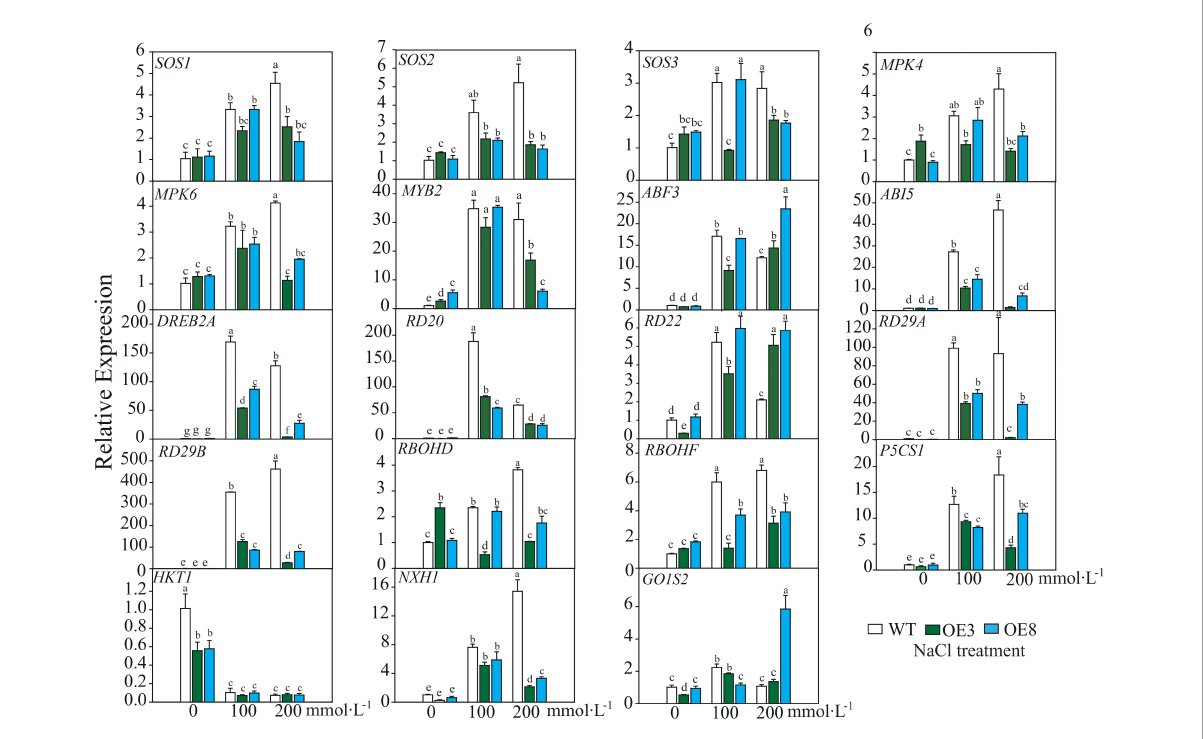
FIGURE9 Relative expression of salt stress responsive genes of WT and OE lines. SOS , Salt Overly Sensitive; MPK, mitogen-activated protein kinas; MYB, V-MYB avian myeloblastosis viral oncogene homolog; ABF, ABA response element binding factor; ABI, abscisic acid insensitive, DREB, dehydration responsive element binding proteins 2; RD, responsive to desiccation; RBOH, respiratory burst oxidase homolog; P5CS, (cid:49) 1-pyrroline-5-carboxylate synthetase; HKT, high-affinity potassium transporter; NHX, Na + /H + antiporter; GolS, galactinol synthase. Mean ± SD, n = 3, lowercase letters indicate significant difference between samples ( p ≤ 0.05, two ways